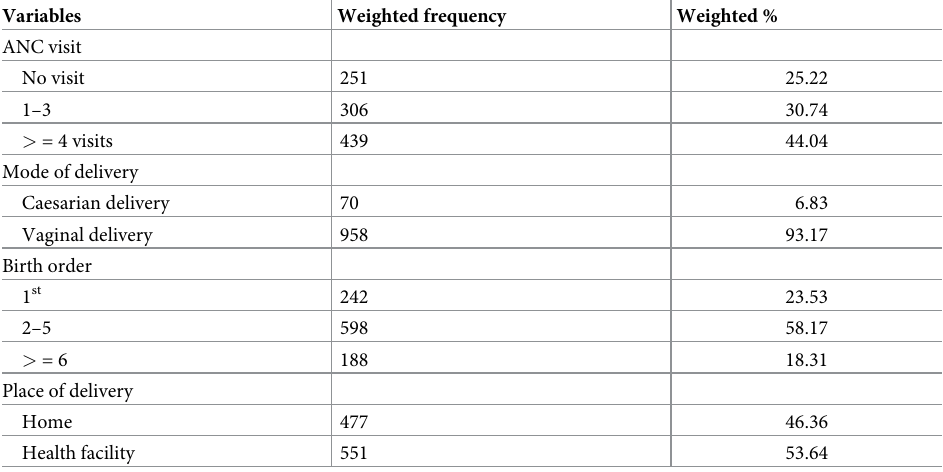
Table 2. Maternal and child health-related characteristics.